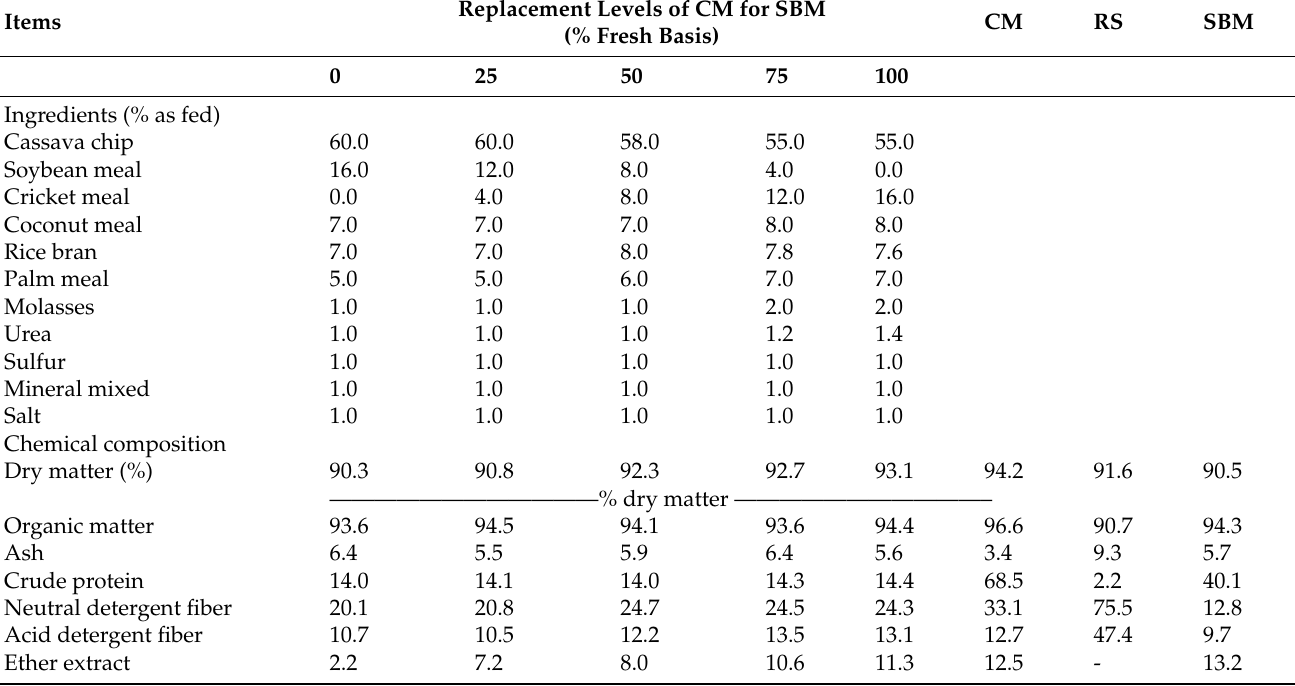
Table 1. Feed ingredients and chemical composition of concentrate, cricket meal ( Gryllus bimaculatus ), and roughage sources used in the experiment.